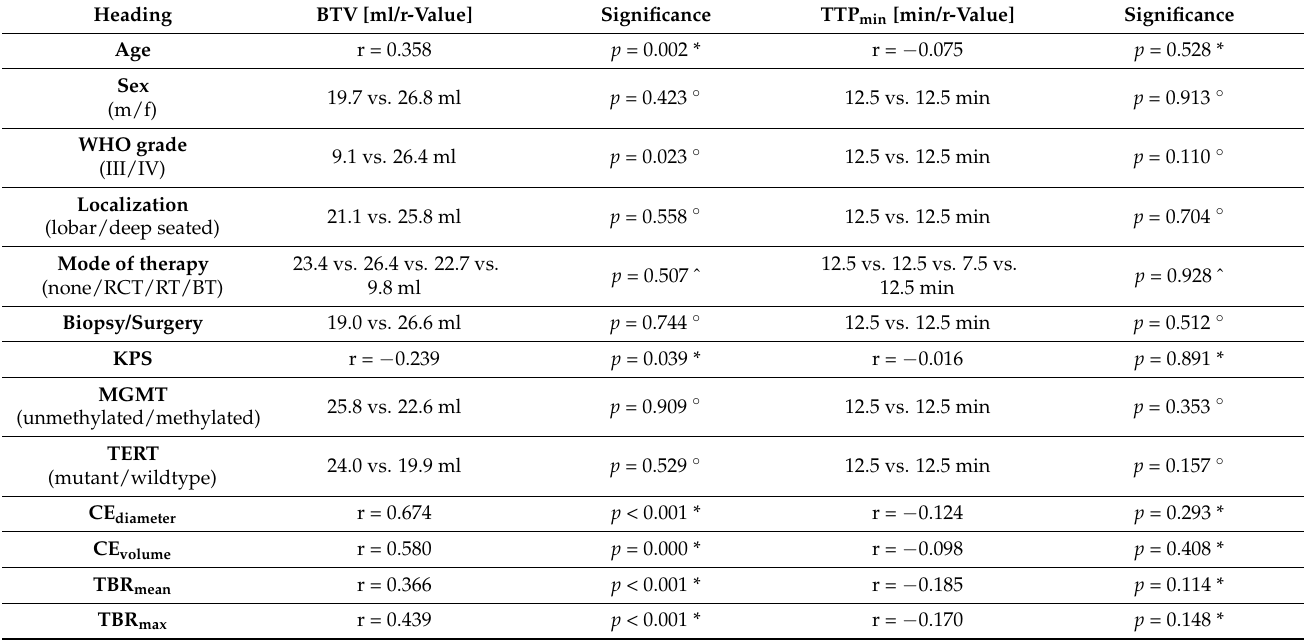
Table 5. Direct comparison/correlation of BTV/TTP min with other